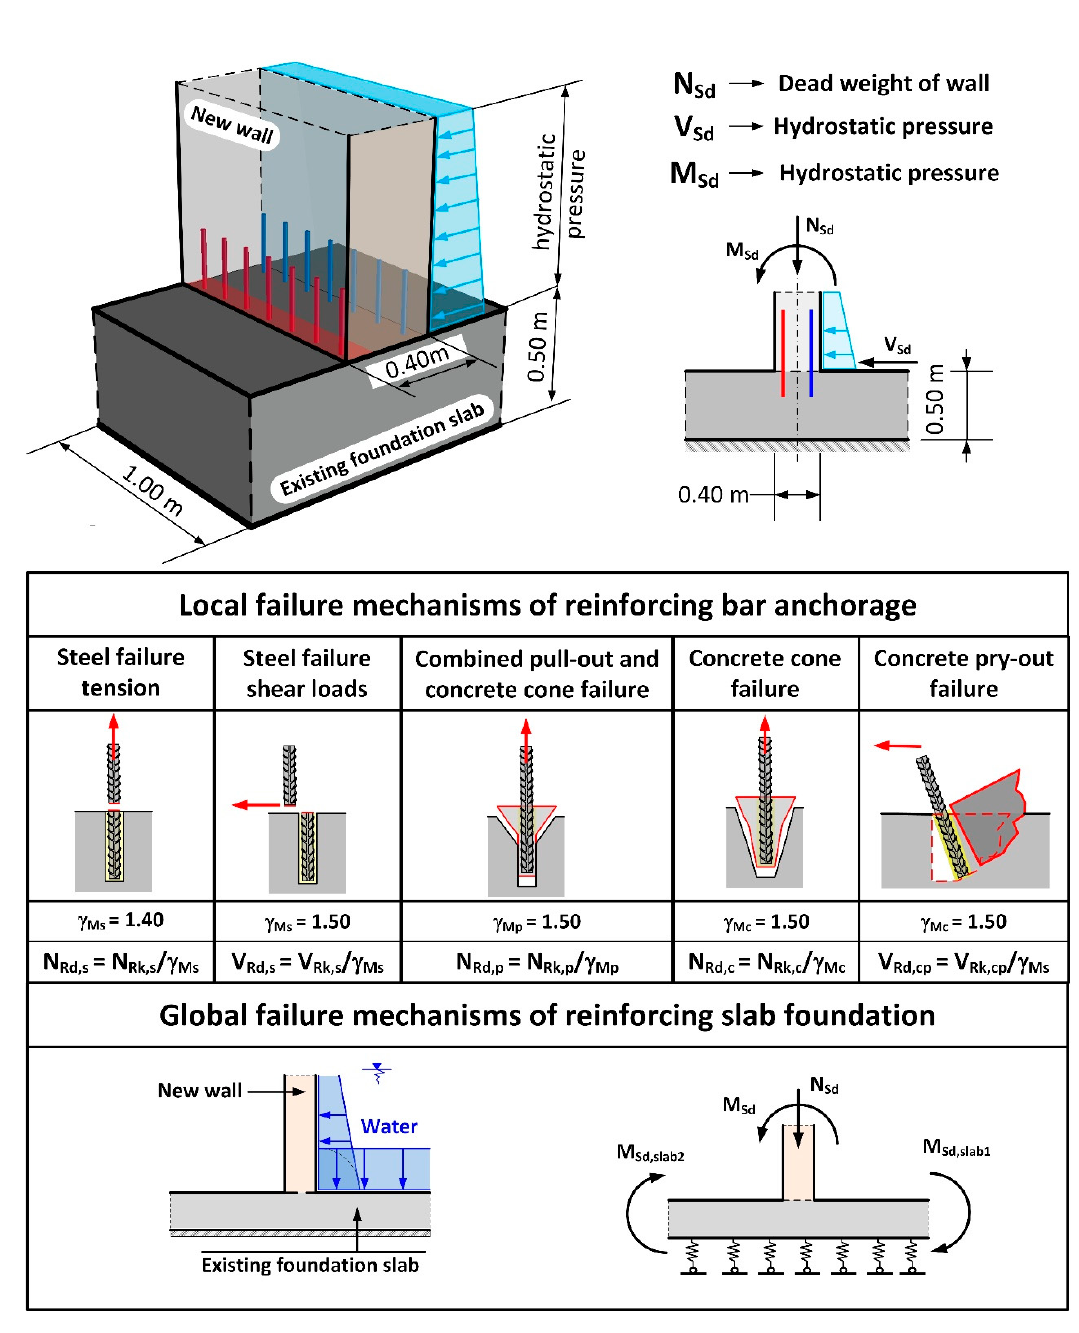
Figure 14. Static diagram of anchoring the wall in the foundation slab of the existing tank. Local failure mechanisms and global failure mechanism considered in the analysis.